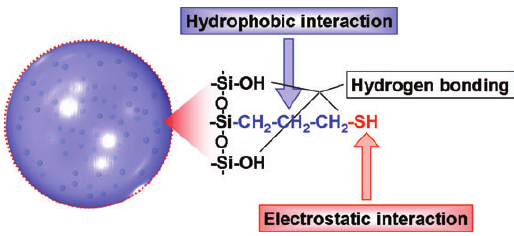
Figure 6 Surface structure and interaction of thiol-organosilica